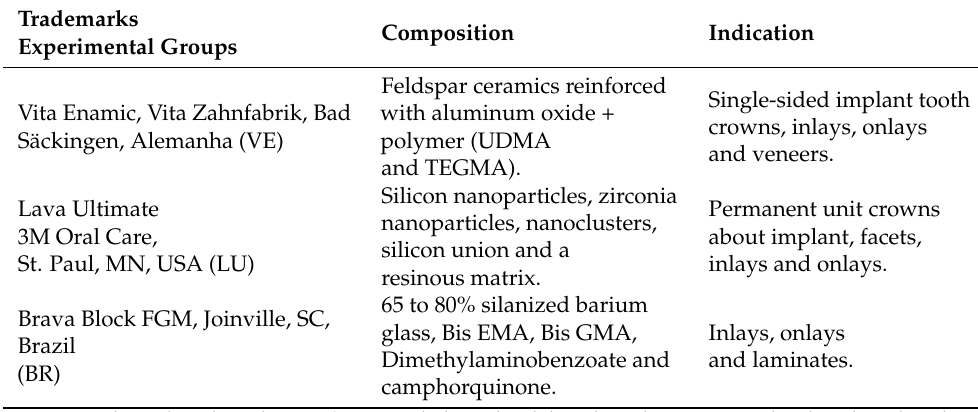
Table 1. Description of materials, manufacturers, compositions, and indications of CAD–CAM